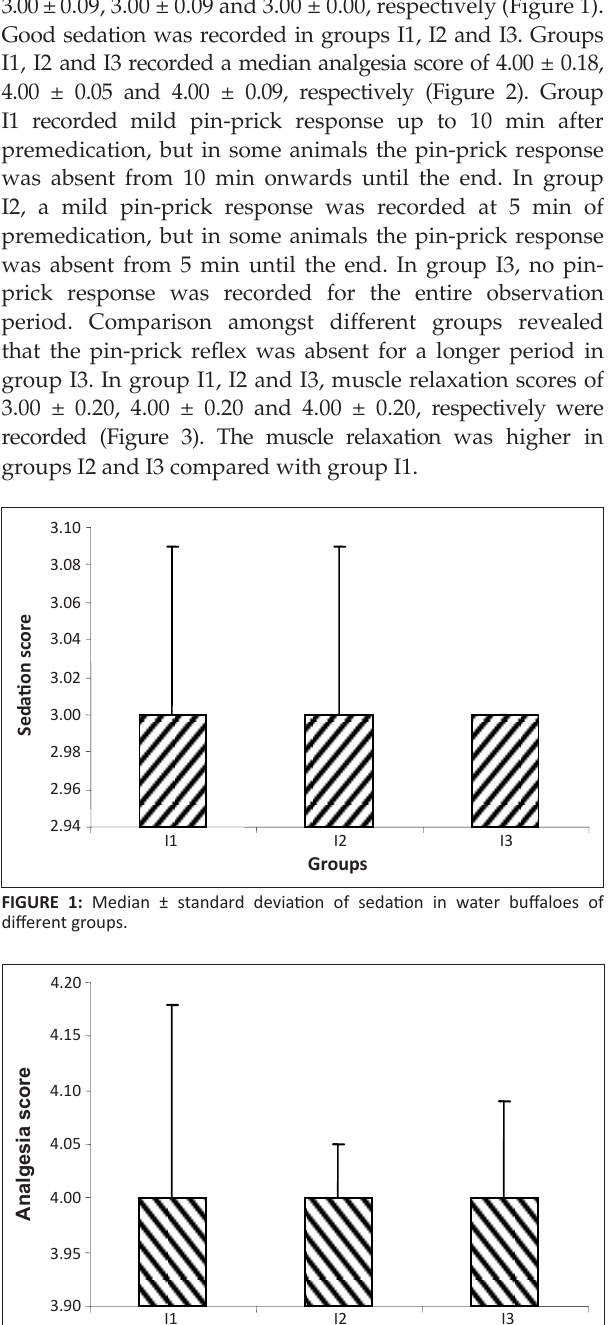
I1 FIGURE 2: Median ± standard deviation of analgesia in water buffaloes of different groups.